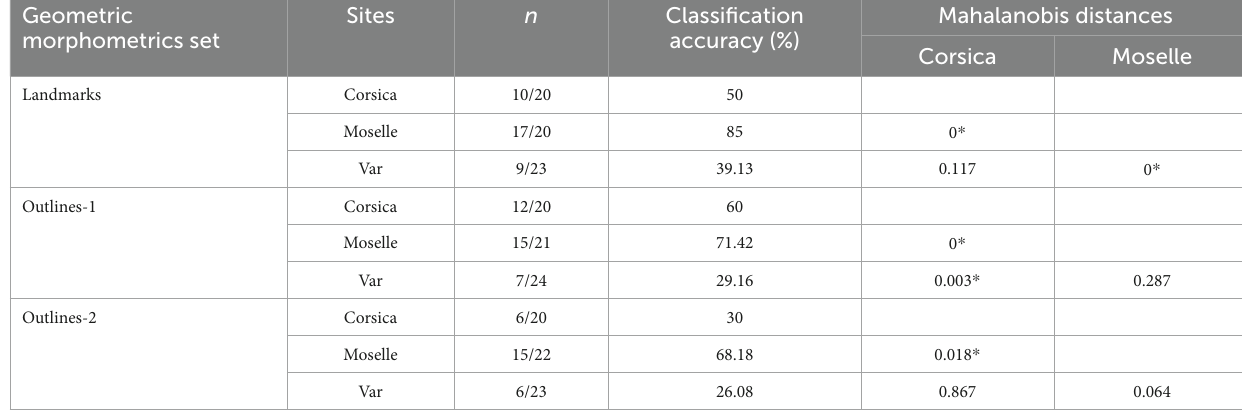
TABLE 3 Mean validated reclassification scores of Culicoides circumscriptus populations from three French sites according to geometric morphometrics (landmarks, outlines, Mahalanobis distances for landmarks, outlines-1 and outlines-2). Geometric Sites n Classification Mahalanobis distances morphometrics set accuracy (%) Corsica